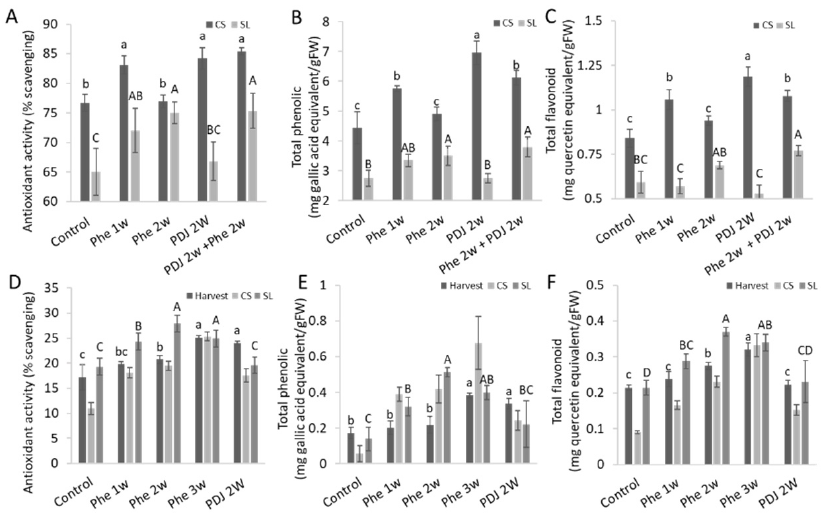
Figure 3. Effect of preharvest treatment with 0.12% Phe or 0.2% PDJ on antioxidant, phenolic, and flavonoid content in mango (cv. Kent) and apple fruit (cv. Cripps pink) at harvest, after cold storage (CS), and shelf-life (SL). Antioxidant activity, total phenolic, and total flavonoid content were evaluated from mango peels (cv. Kent) ( A − C ), apple (cv. Cripps pink) ( D − F ) peels. Mean values and standard errors are presented. Statistical analysis was conducted for each time point separately (small or capital letters). Different letters represent significant differences ( p ≤ 0.05).